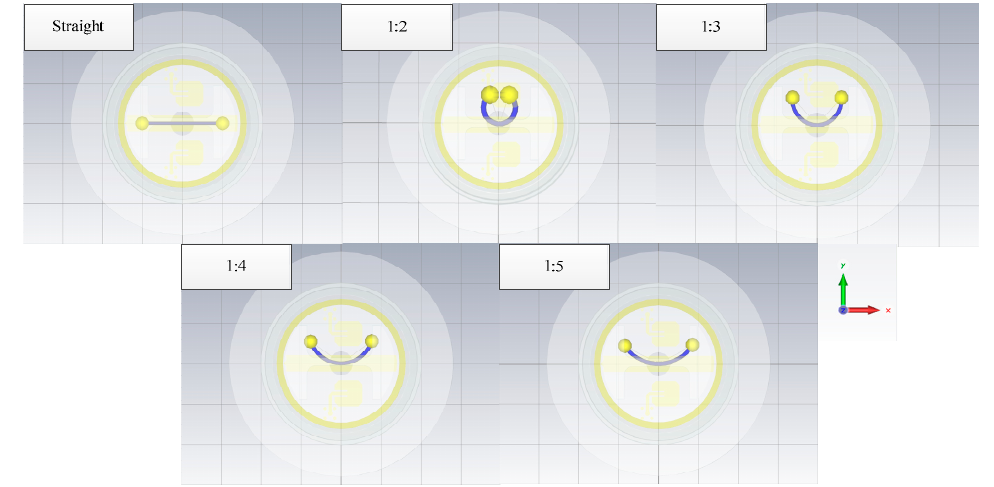
Figure 17. The geometry of the wires.